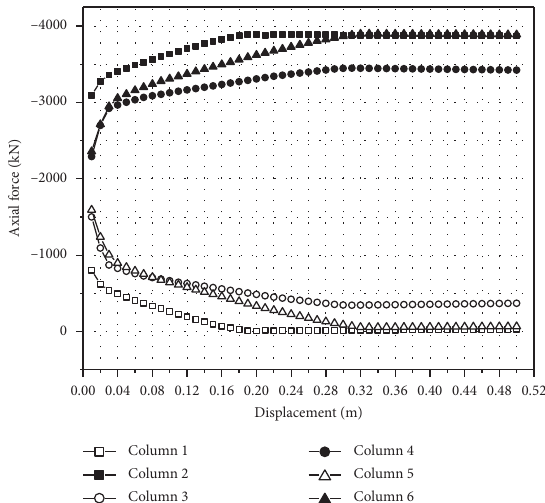
Figure 35: Moment-displacement at the top of typical